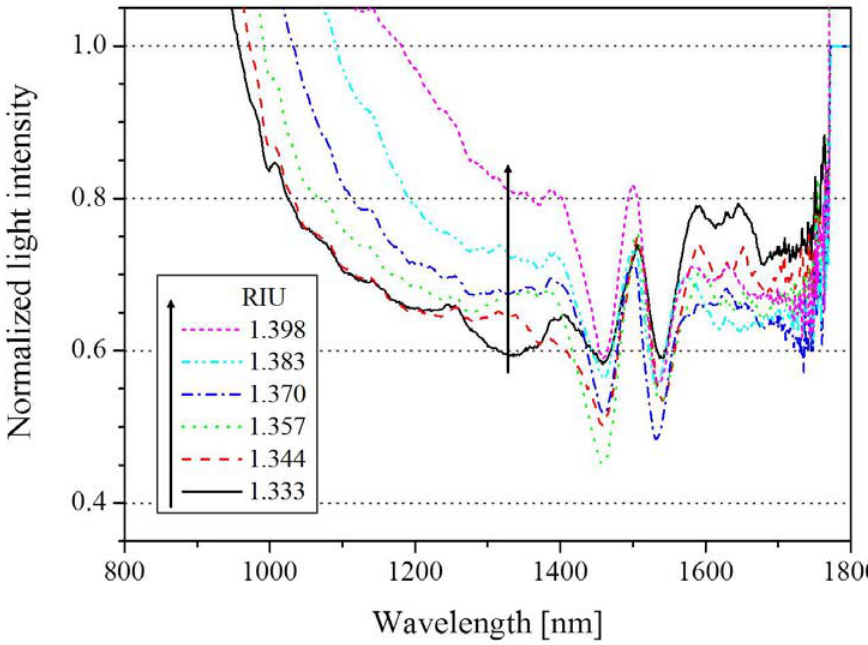
O were 25 nm and 60 nm, 2 5